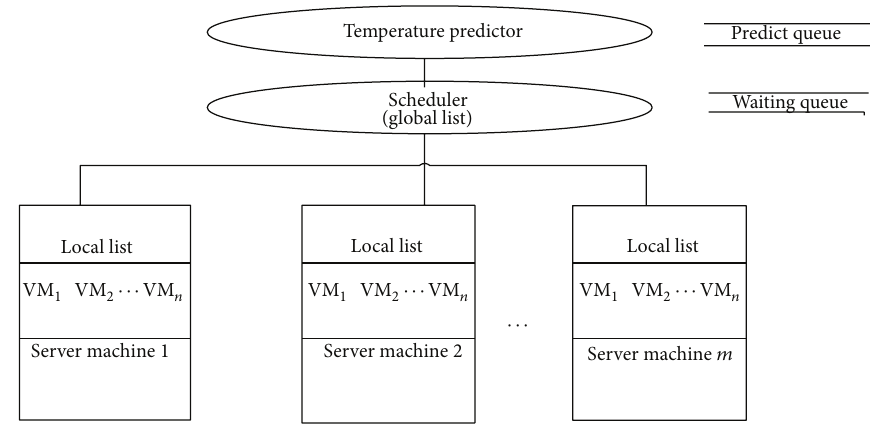
Figure 3: Proposed system